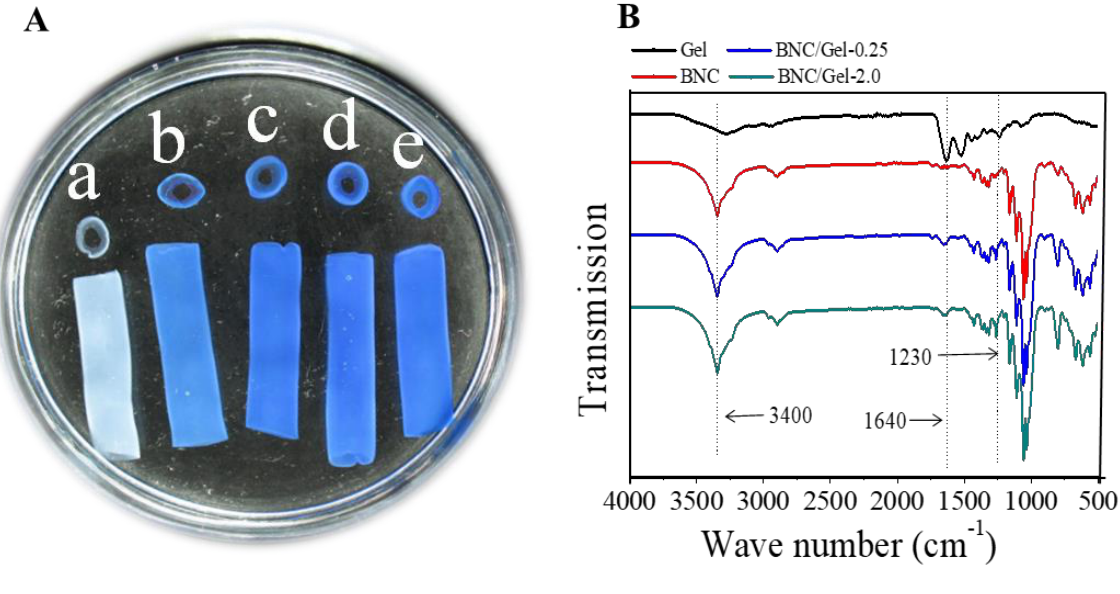
Figure 2. ( A ) Macromorphology with gelatin uniformity visualization for BNC tube (a), BNC/Gel−0.25 (b), BNC/Gel−0.5 (c), BNC/Gel−1.0 (d) and BNC/Gel−2.0 (e) after Coomassie Brilliant Blue G250 staining. ( B ) FTIR spectra of BNC tube and BNC/Gel composite tubes. Table 1. Characterization of BNC/Gel composite